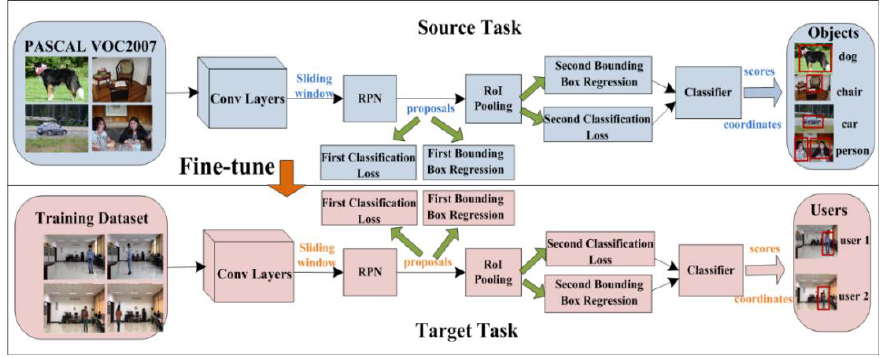
Figure 2. Schematic view of fine-tuning Faster R-CNN (Region Convolutional Neural Network). IoU is used to evaluate the performance of location which measures the overlapping ratio of the bounding boxes between predication and